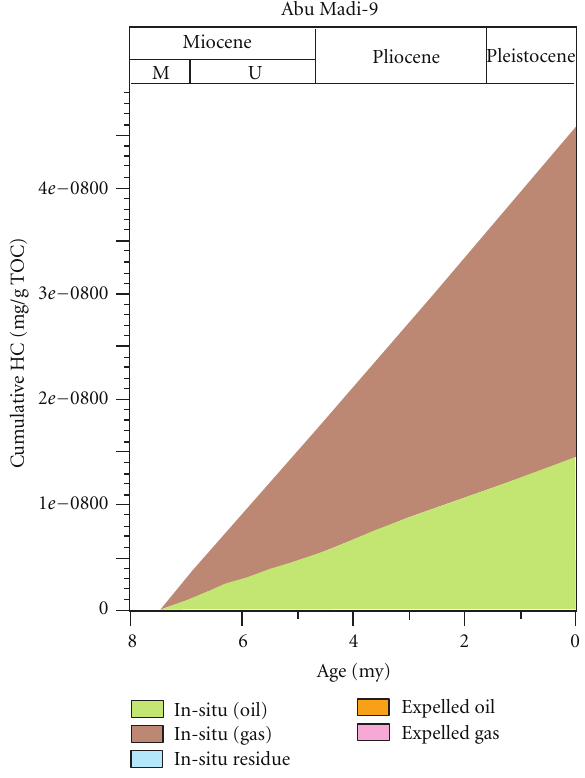
Figure 12: Calculated (cumulative model) of hydrocarbon gener- ation from organic matter in the Abu Madi formation from Abu Madi-9 well, Abu Madi/El Qar’a Gas field.